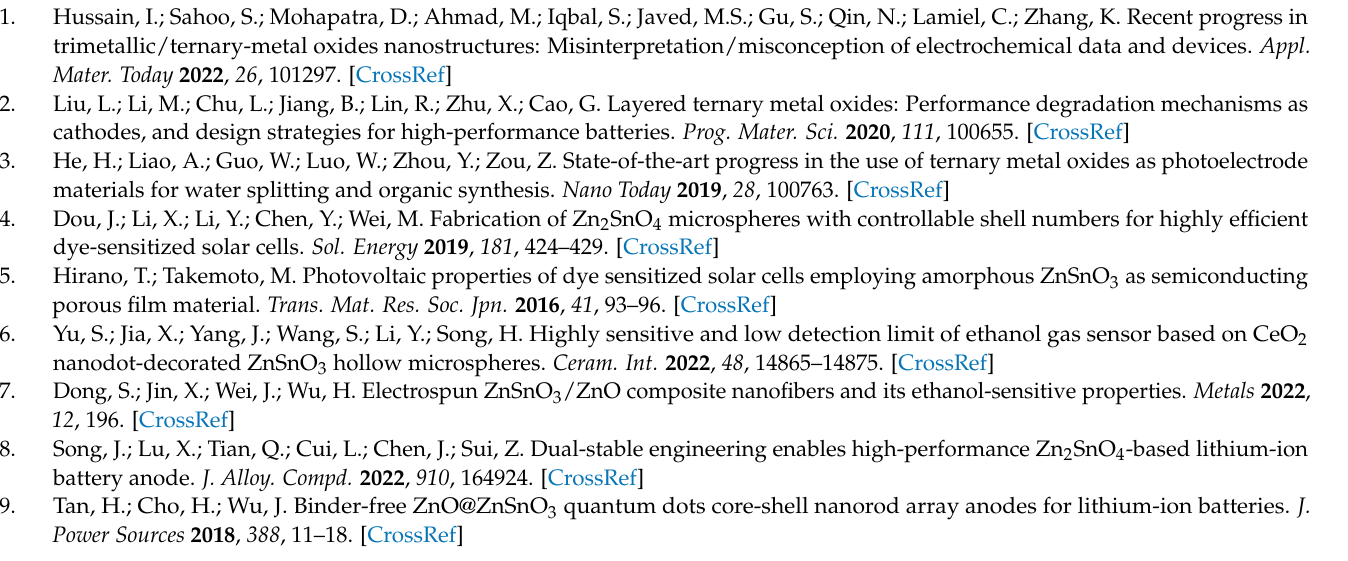
pore size distribution curves; Figure S5: Schematic illustration of light reflections and refractions in S 2 ; Figure S6: ZnSnO 3 nanosheets: (a) UV-vis absorption spectra; (b) Mott-Schottky plots; Inset of (a): the corresponding Tauc’s curves; Figure S7: The estimated current density by integrating the IPCE spectrum; Figure S8: Controlling experiments using different radical scavengers for the removal of CIP and Cr(VI); Table S1. The calculated results of the samples about band gap energy (E g ), flat band potential (E fb ), E CB and E VB ; Table S2: Detailed photovoltaic parameters of solid Zn 2 SnO 4 -based DSSCs with film thicknesses of 10 µ m and various dye-loading times; Table S3: Detailed photovoltaic parameters of DSSCs based on the Zn 2 SnO 4 photoanode with different film thicknesses; Table S4: Detailed photovoltaic parameters of ZnSnO 3 /Zn 2 SnO 4 -based DSSCs with film thicknesses of 12 µ m and various dye-loading times; Table S5: Comparison of the photovoltaic performance of ZnSnO 3 /Zn 2 SnO 4 hollow octahedrons against previously reported DSSCs; Table S6: The fitting results about photocatalytic removal of the pollutants over the different